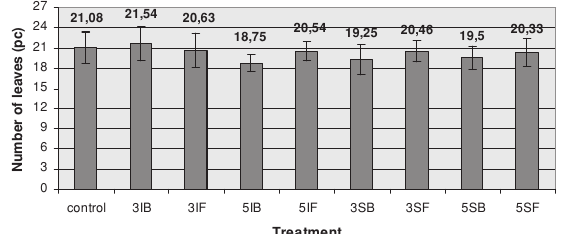
Figure 2. The effect of treatments on the number of leaves of Saintpaulia ionantha (6 th February 2009